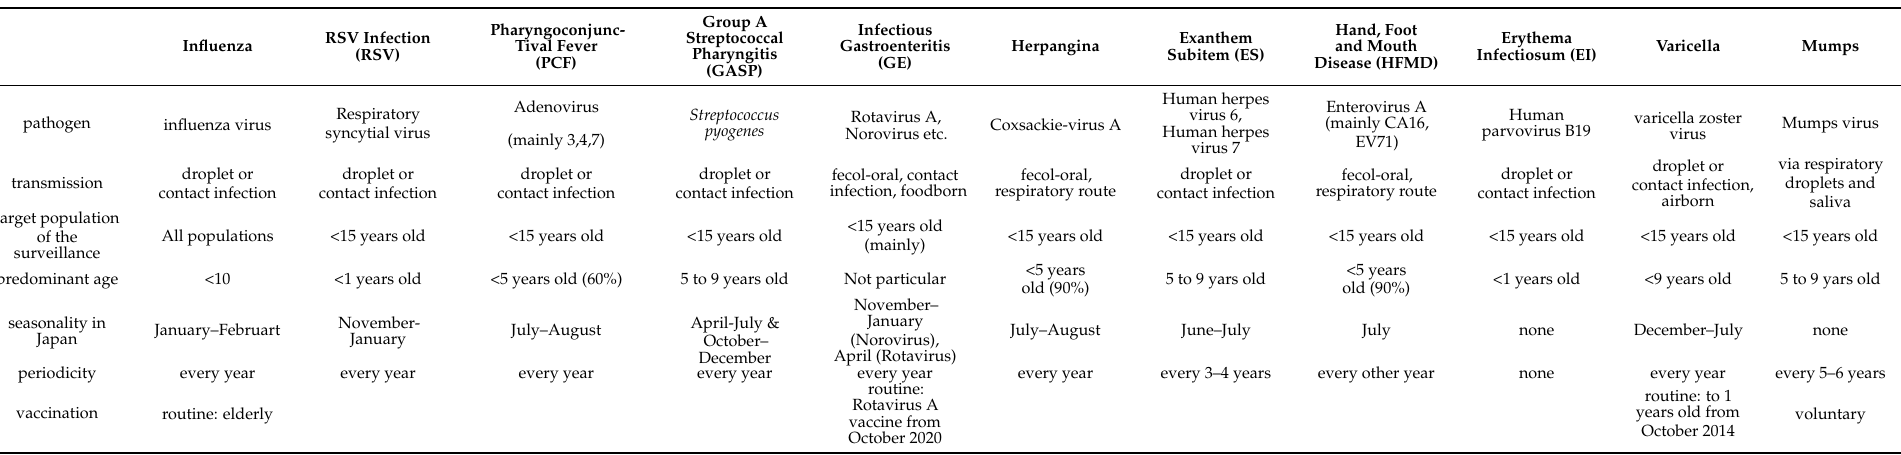
Table 1. Summary of the 11 infectious diseases reported by sentinel hospitals in